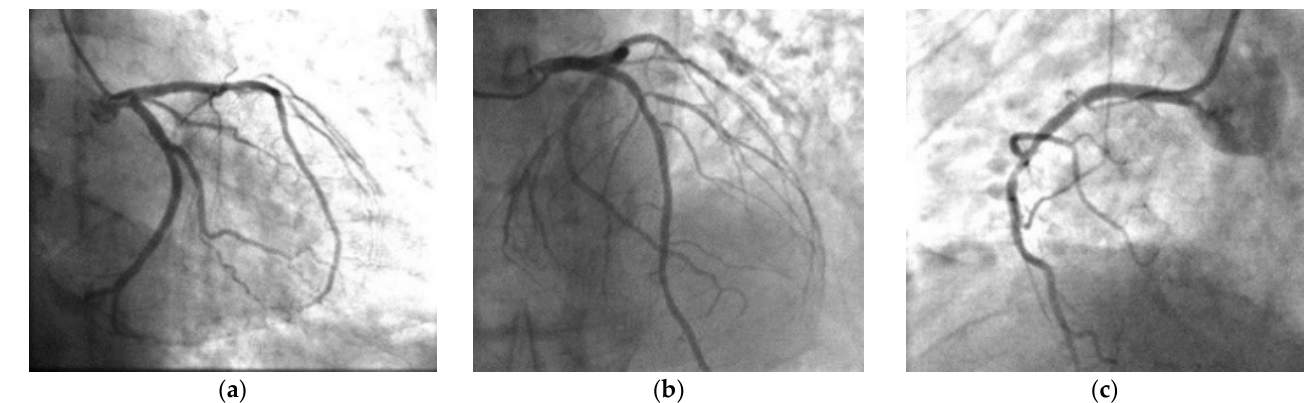
Figure 2. Cardiac catheterization. Right anterior oblique, ( a ) caudal and ( b ) cranial of left coronary anatomy (stenosis 40% on the first diagonal). Left anterior oblique, ( c ) cranial of right coronary anatomy (stenosis 50% on the proximal right coronary).